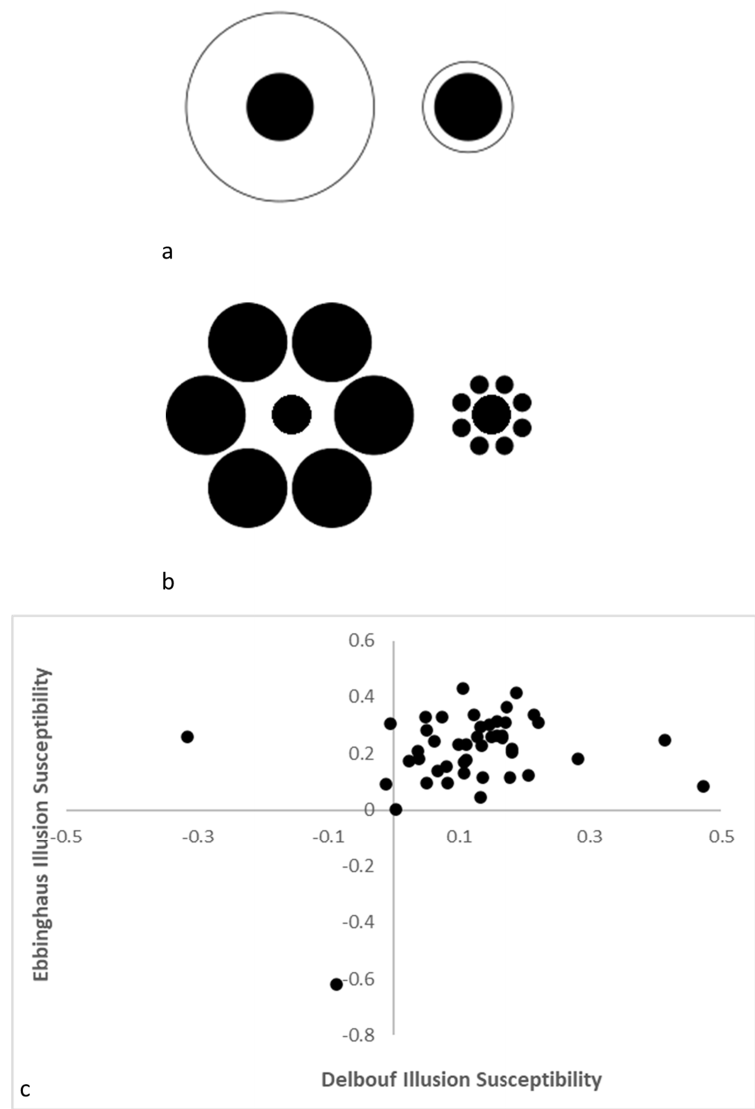
Figure 2. The Delboeuf ( a ) and Ebbinghaus ( b ) illusions in which the central dots surrounded by a smaller perimeter ring or a series of smaller other dots (i.e., the right stimuli in each image) are overestimated relative to when the surrounding ring or series of circles are large. The relative susceptibility to each of these illusions in a sample of 46 adult humans where positive values indicate the typical illusory experience ( c ).